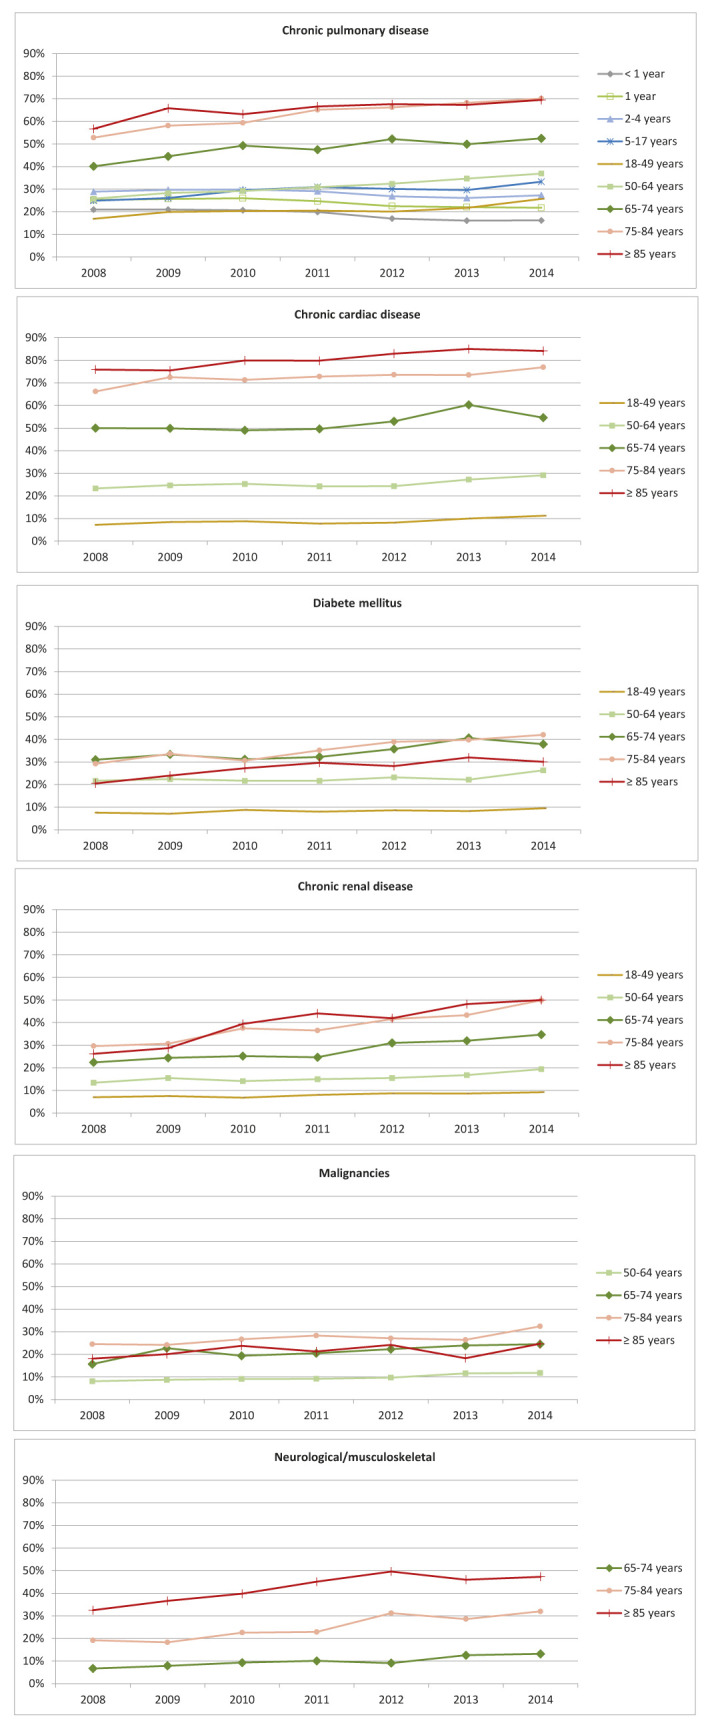
High-risk conditions in RSV patients, 2008-2014. Includes patients with an RSV-specific ICD-9-CM code (079.6, 466.11 or 480.1). Note: Most common high-risk conditions (>20%). Age groups with <10% were not represented in graphs. For conditions and International Classification of Diseases, 9th revision, Clinical Modification (ICD-9-CM) codes for each subgroup of high-risk conditions see Appendix S1 n the Online Supplementary Document.